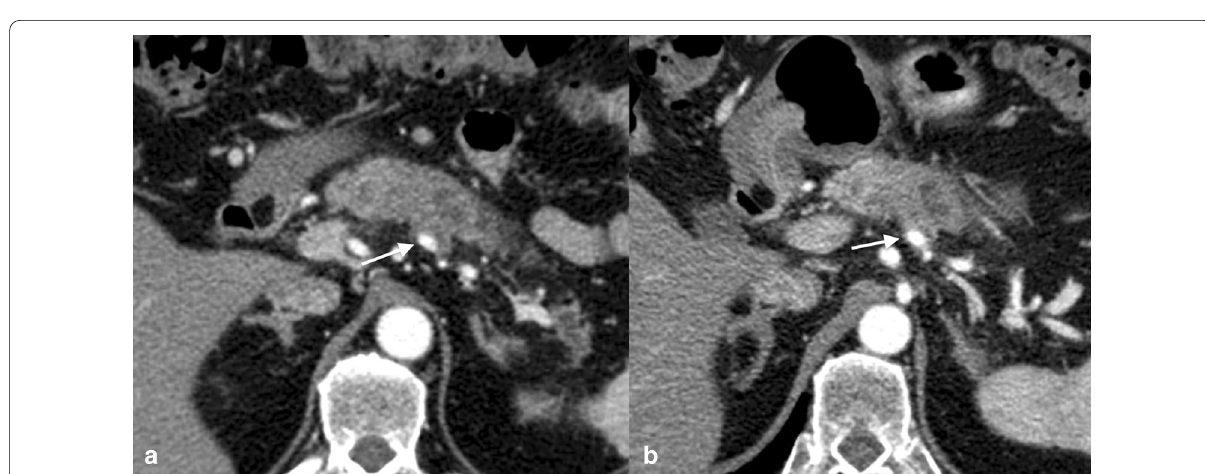
Fig. 19 Effects of neoadjuvant ChT/RT in a 63-year-old male with pancreatic body ductal adenocarcinoma. Baseline CT scan ( a ) shows a hypodense lesion consistent with pancreatic ductal adenocarcinoma in the pancreatic body infiltrating the splenic artery (arrow); concurrent infiltration of the celiac trunk and the splenic vein was present. In the CT scan ( b ) performed after neoadjuvant ChT/RT (FOLFIRINOX tumor mass was slightly reduced in size, but persistent soft-tissue attenuation was present around the splenic artery (“perivascular cuff”—arrow). The patient underwent surgical exploration with successful distal pancreatectomy and celiac artery resection (Appleby procedure); pathological examination of the resection specimen showed absence of residual disease, negative resection margins, and fibrosis around the splenic